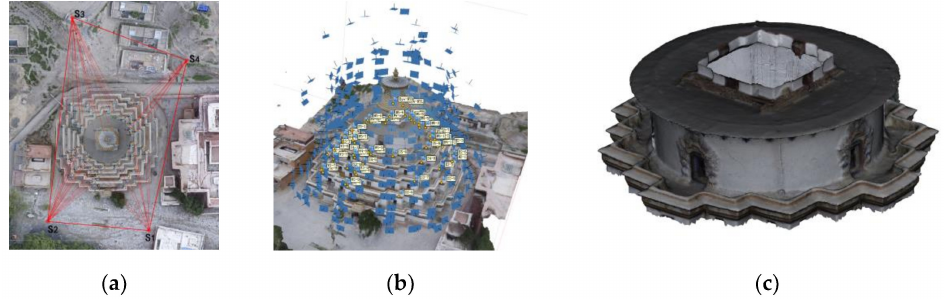
Figure 4. The ground truth model (GTM) of the Stupa. ( a ) The geodetic network measured with a total station; ( b ) image positions and ground control points (GCPs) of the entire Stupa; and ( c ) the mesh